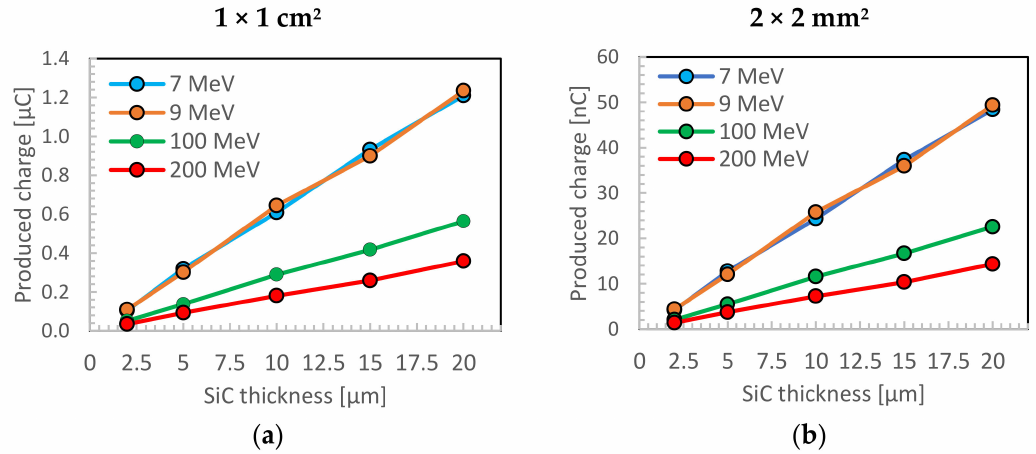
Figure 2. Produced charge within a 1 × 1 cm 2 ( a ) and 2 × 2 mm 2 ( b ) SiC detector for electron beams of 7 MeV, 9 MeV, 100 MeV and 200 MeV delivering an equivalent dose in water of 2 Gy. Results are obtained by means of Monte Carlo Geant4 simulations for SiC active thicknesses of 2 µ m, 5 µ m, 10 µ m, 15 µ m and 20 µ